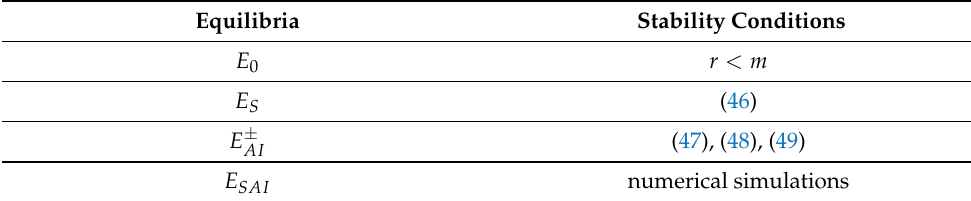
Table 5. Summary of equilibria and their local stability for model